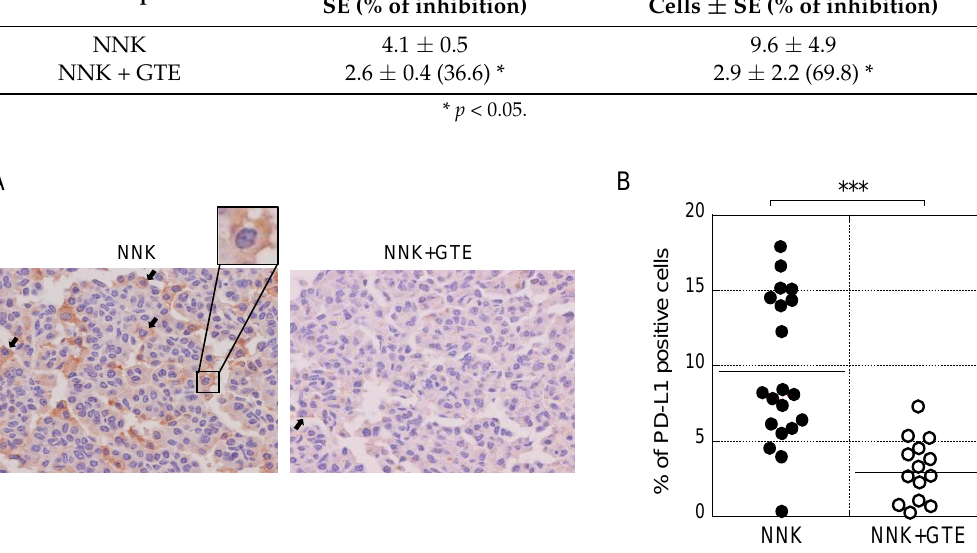
Figure 4. Oral administration of GTE reduced PD-L1–positive cells and inhibited tumor development in the lungs of NNK-treated A/J mice. ( A ) Representative immunohistochemical staining with anti–PD-L1 antibody. Black arrows indicate PD-L1–positive cells on the plasma membrane. ( B ) Average percentage of PD-L1–positive cells in individual tumors. *** p < 0.001.